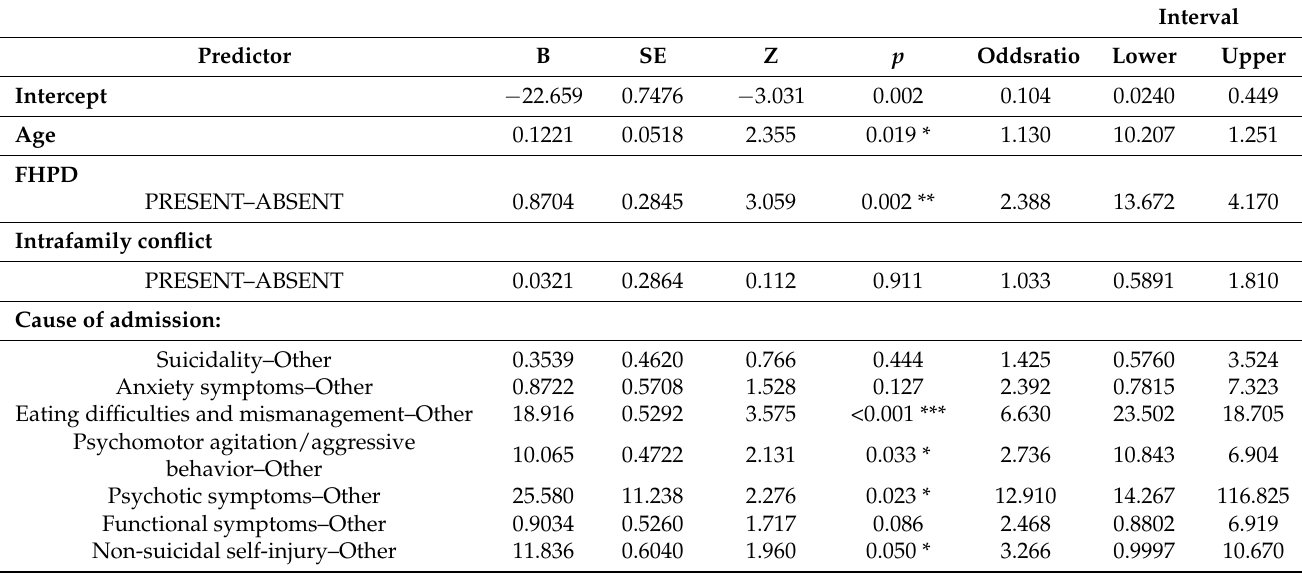
Table 6. Logistic